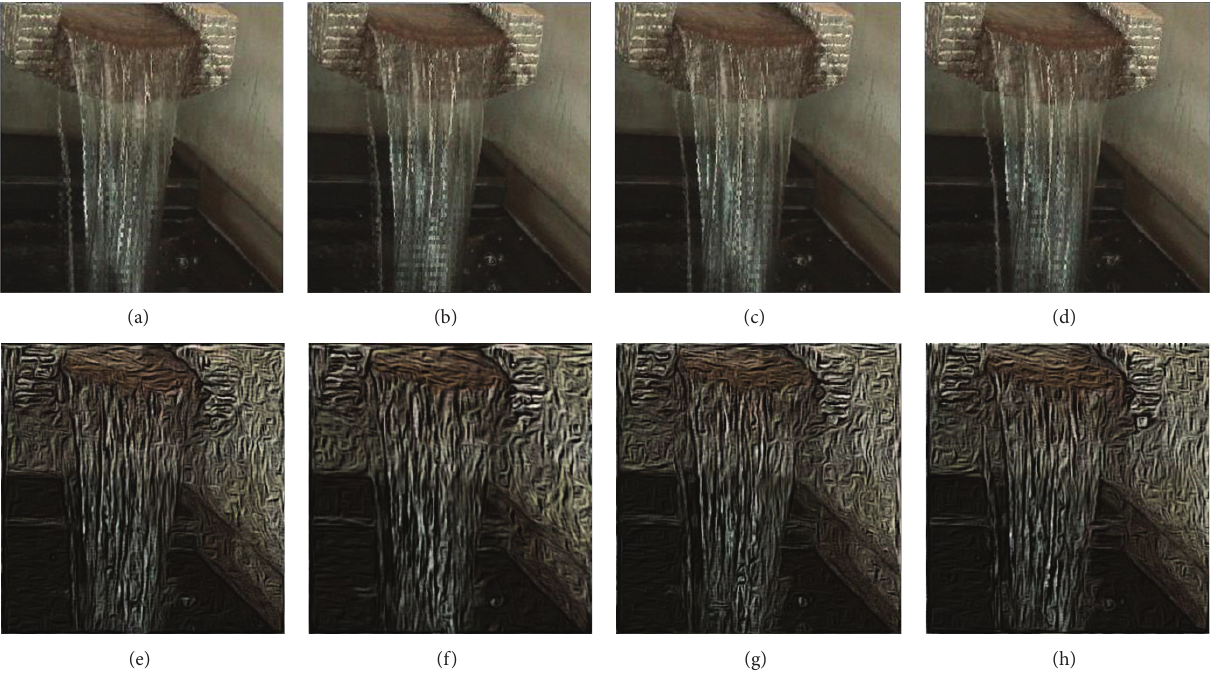
Figure 8: Video texture of blowing water.